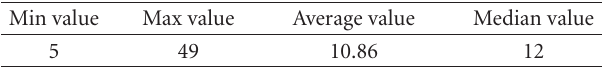
Table 3: Time needed during the content search activity (msec).